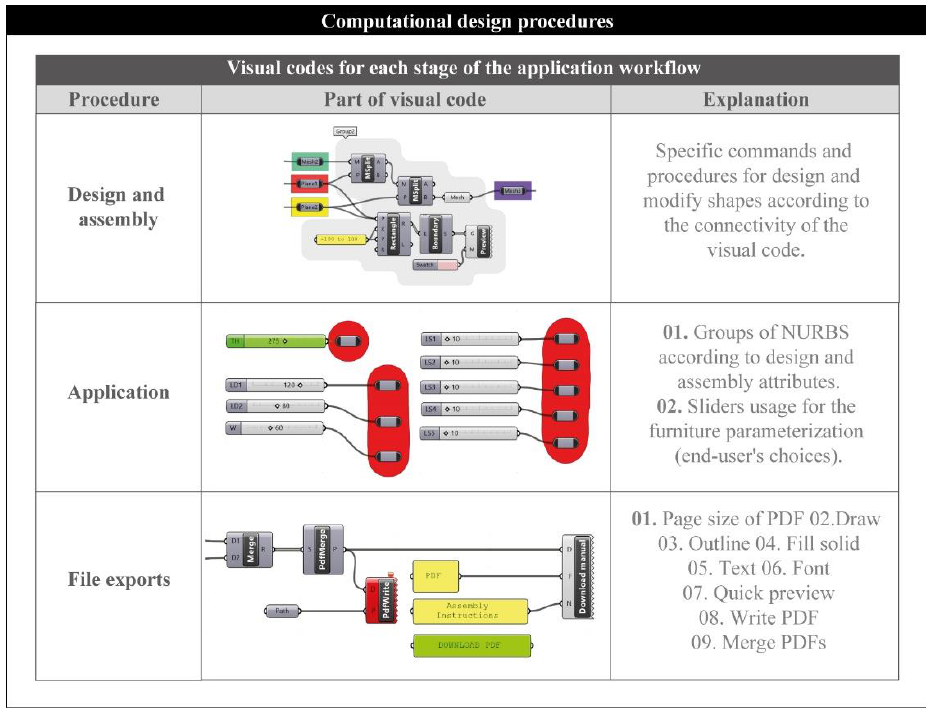
Figure 11. Computational design procedures.